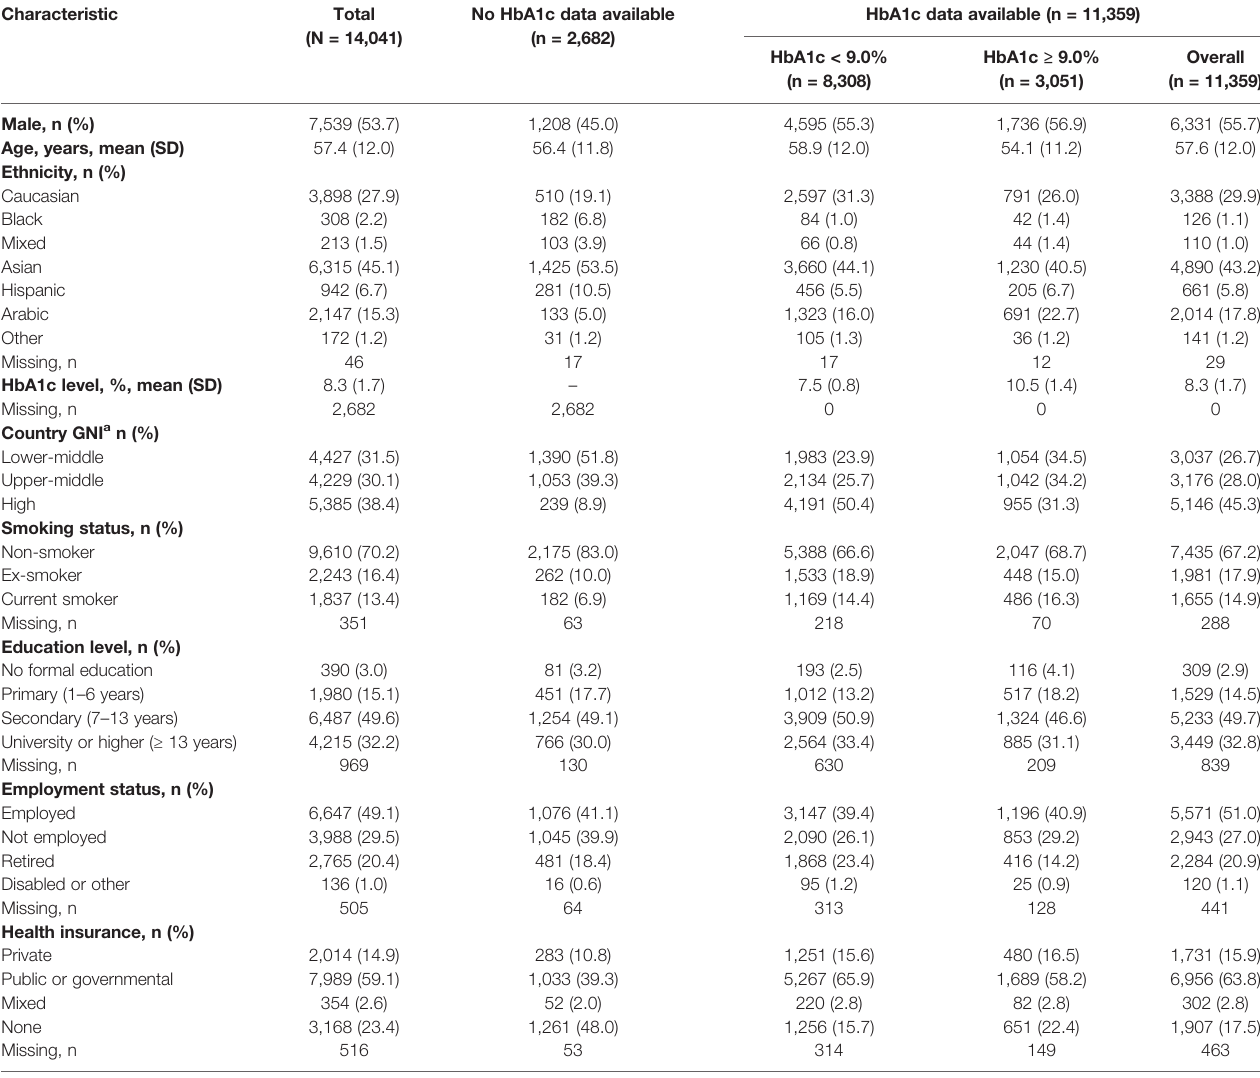
TABLE 1 | Baseline demographic and clinical characteristics of DISCOVER study participants overall, and with and without an available baseline HbA1c measurement. Characteristic Total (N =